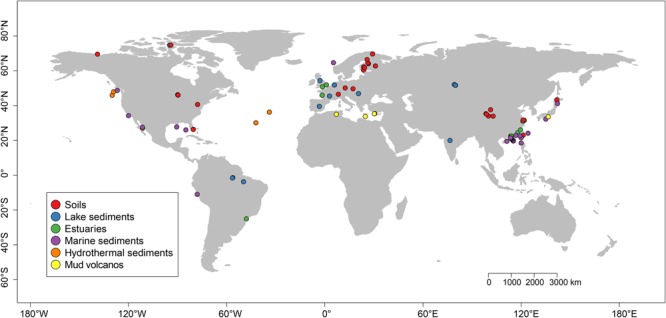
Location of the sites used for this study. The sites were grouped into six different categories according to their habitats and were labeled with different colors. A summary of the six habitats is given in Supplementary Tables S1, S2.